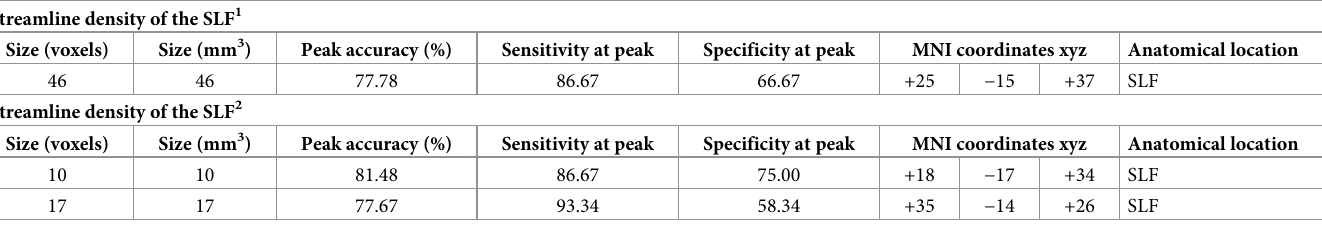
Table 4. Structural connectivity classification